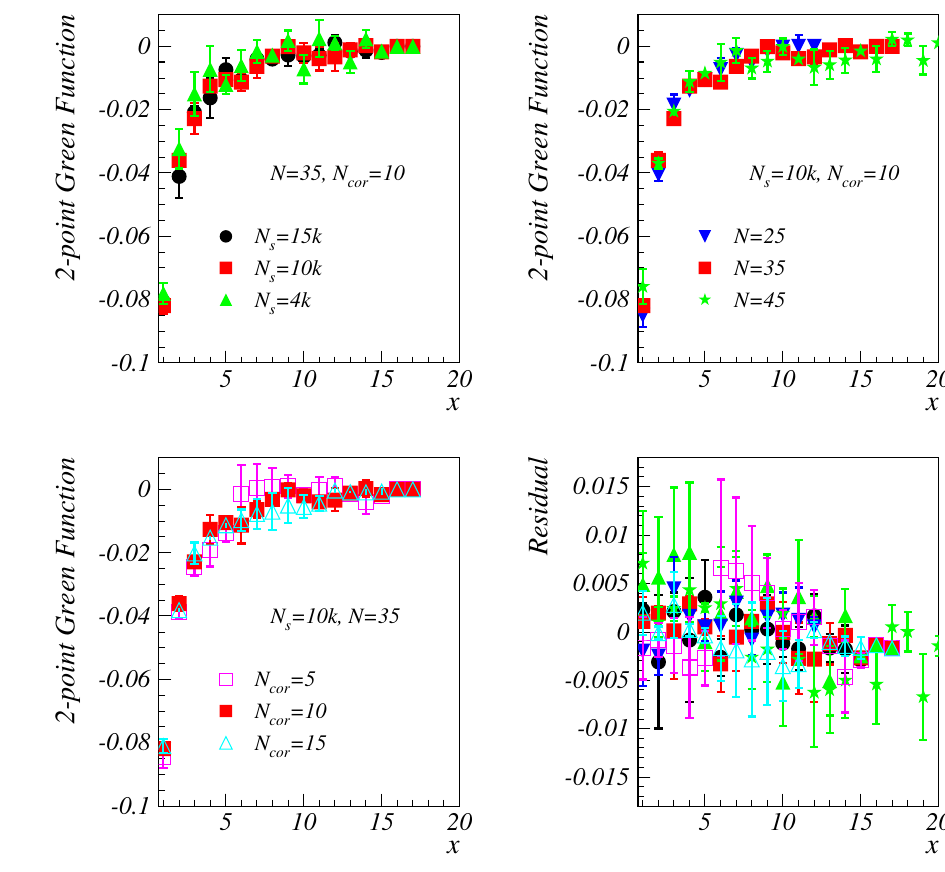
Fig. 14 Potentials for various values of parameters used in the simulation. Only the quadratic term ∂φ∂φ in the Lagrangian (massless free-field case) was kept. For these simulations the system size N , the decorrelation parameter N cor , and the statistics N s , are varied. In the bottom right panel , the residuals between the results and the expected 1/ x behavior are shown. The vertical axis span is the same as for the three first panels and magnified by a factor 3 for the bottom right panel showing the